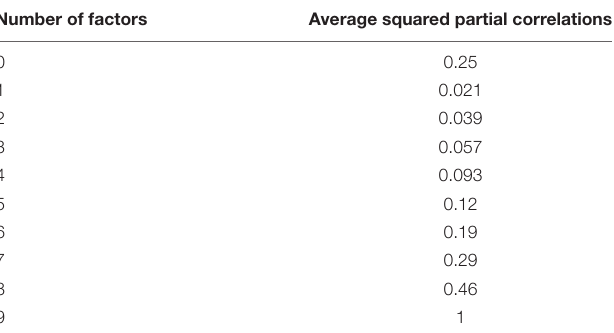
TABLE 1 | The minimum average partial test for determining the number of factors to retain for the exploratory factor analysis in the population-based sample ( N = 687).